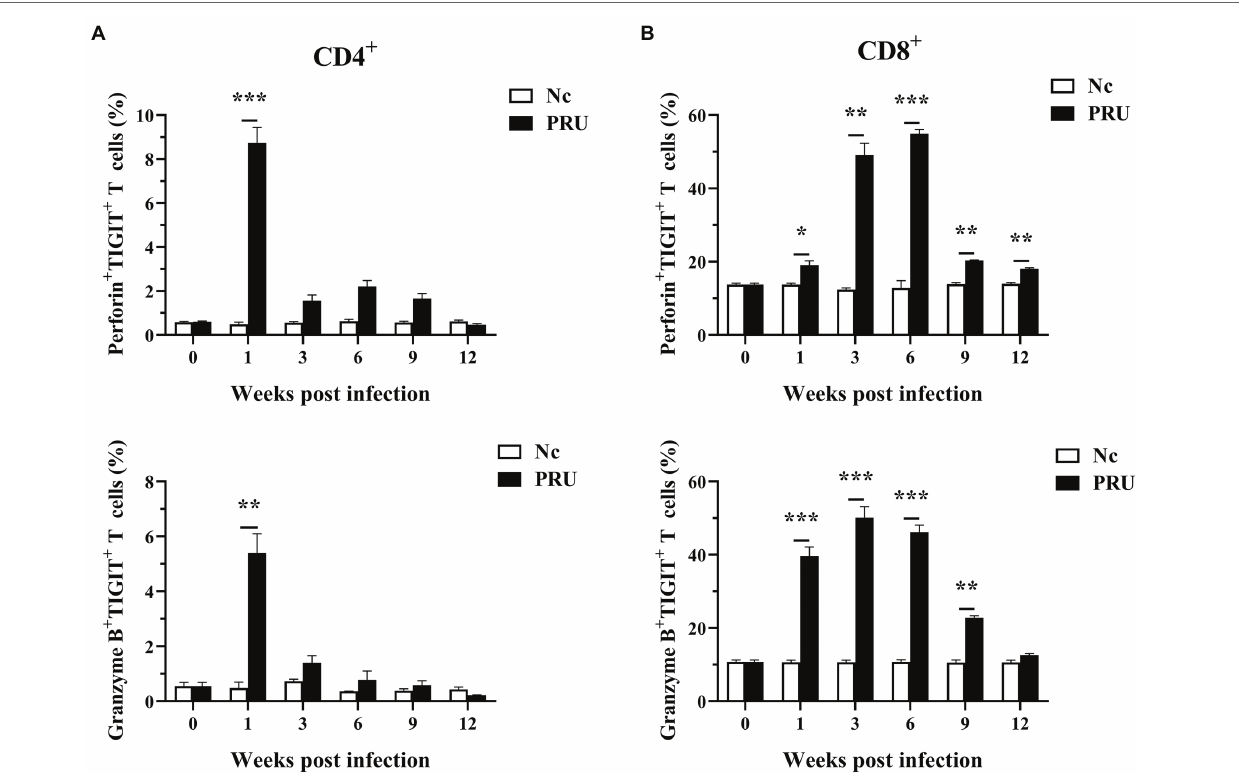
FIGURE 5 | Cytotoxic activity of TIGIT + T cells in spleen after T. gondii infection. (A) Dynamic changes in TIGIT + CD4 + T cell cytotoxicity in the spleen of mice chronically infected with T. gondii . (B) Dynamic changes of TIGIT + CD8 + T cell cytotoxicity in the spleen of mice chronically infected with T. gondii . The results are representative of three independent experiments with five mice in each group per experiment, with data denoting means ± SDs. * p < 0.05, ** p < 0.01, and *** p < 0.001 (compared to the